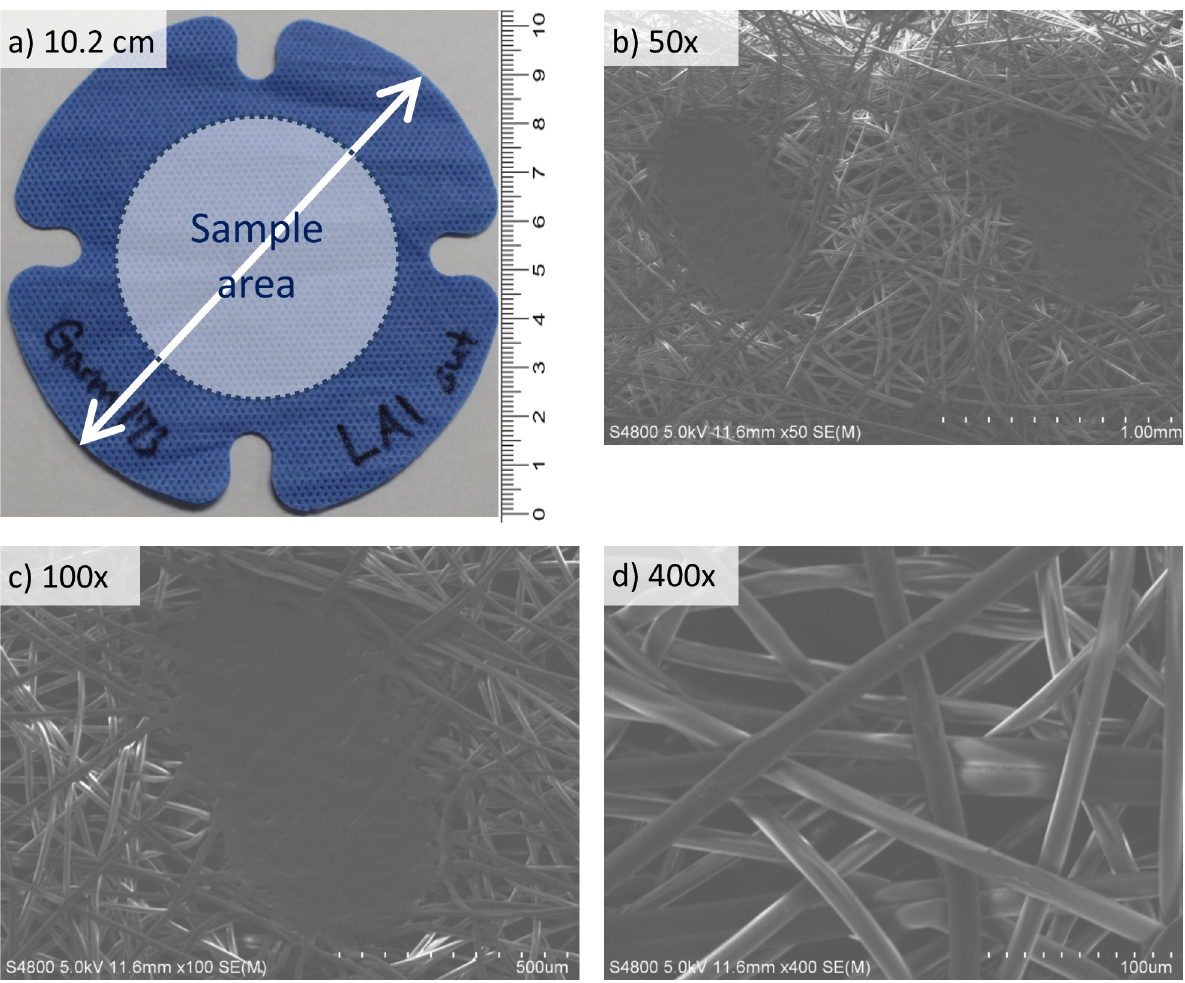
Fig 2. ANSI/AAMI Level 3, five layer, non-woven, spunbond and melt blown surgical gown specimen: a) exterior side having a 10.2 cm outer diameter and a 25.65 cm 2 sample area, b) 50x magnification, c) 100x magnification, and d) 400x magnification.